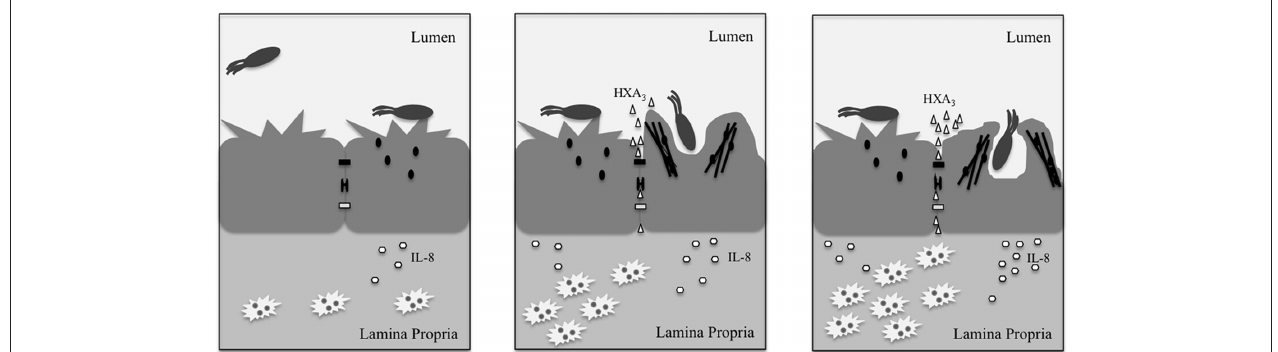
FigurE 2 | upon interacting with the epithelial cell, Salmonella secrete white ovals) are recruited via basolateral secretion of IL-8, and subsequently effectors (small black ovals) that promote release of the neutrophil migrate from the basolateral surface to the apical surface to the point of chemoattractant, HXA (small triangles), and membrane ruffling as a result infection due to the HXA gradient. The actin re-organization alters the 3 3 of actin (black lines) re-organization. The release of HXA from the apical morphology of the cell membrane at the apical surface in a manner that 3 (mucosal) surface creates a concentration gradient across tight junctions (small promotes Salmonella uptake via macropinocytosis. Once inside the cell, black rectangle), desmosomes (small black bracket), and adherens junctions Salmonella reside within a compartment termed the SCV that forms as a result (small white rectangle) and through the paracellular space. Neutrophils (jagged